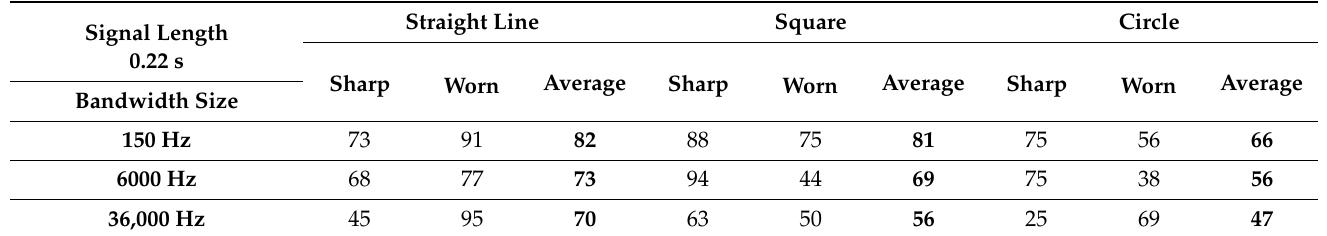
Table 3. Tool wear classification rate with the AE signal (model trained by straight line